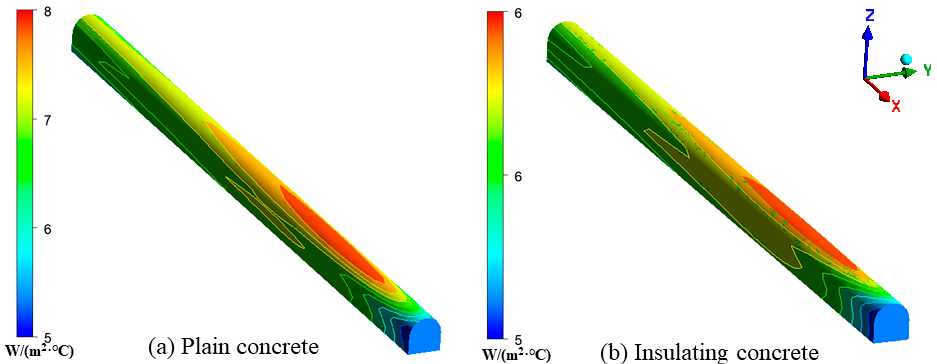
Figure 19. Distribution of convective-heat-transfer coefficients between the wall of the roadway and the wind flow: ( a ) Distribution of convective heat transfer coefficients of the roadway under plain concrete support; ( b ) Distribution of convective heat transfer coefficients of the roadway under insulated concrete